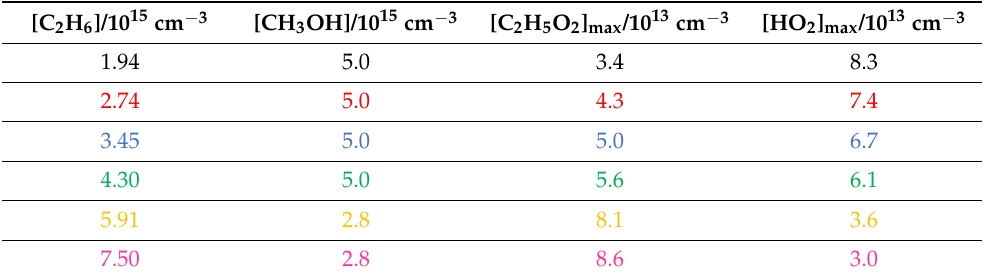
Table 2. Conditions for experiments shown in Figure 6. Initial Cl-atom concentration was for all experiments 1.2 × 10 14 cm − 3 , total pressure was 100 Torr O 2 , T = 295 K. [C 2 H 5 O 2 ] and [HO 2 ] concentration taken from the model. Total radical concentrations are slightly below initial Cl- concentration due to